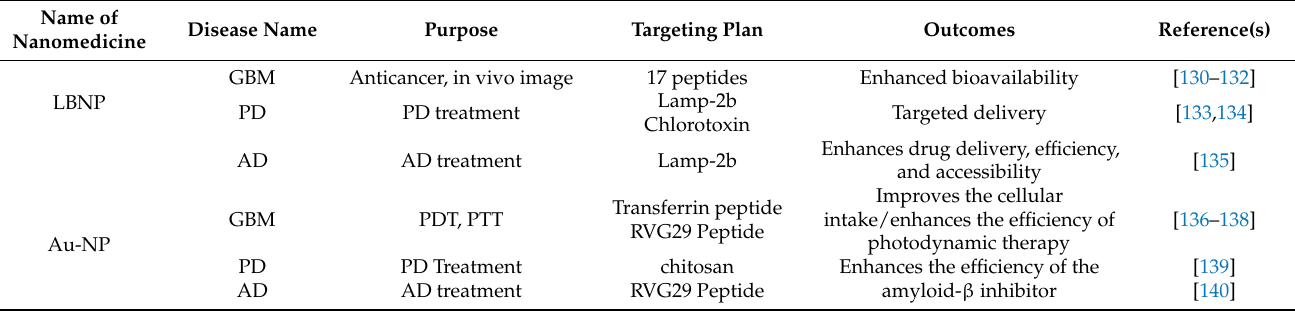
Table 1. List of nanomedicines targeting CNS